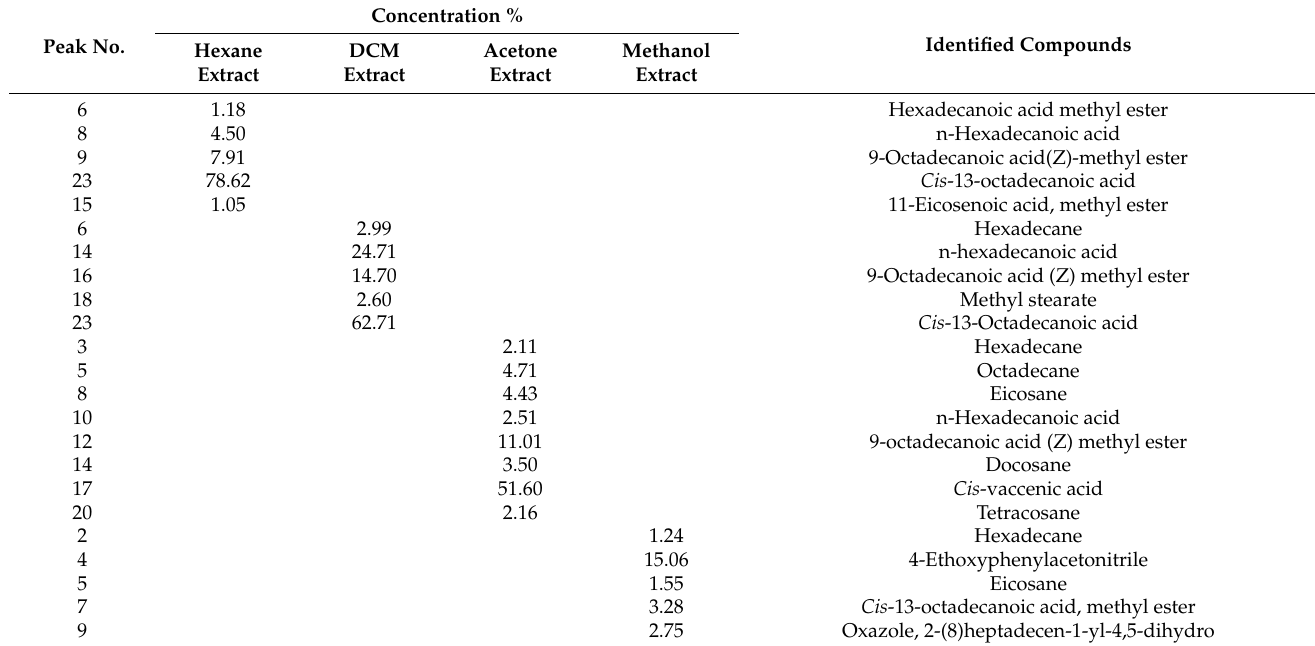
Table 1. Compounds present in hexane, dichloromethane, acetone and methanol extracts of MOS oil determined by one-dimension gas